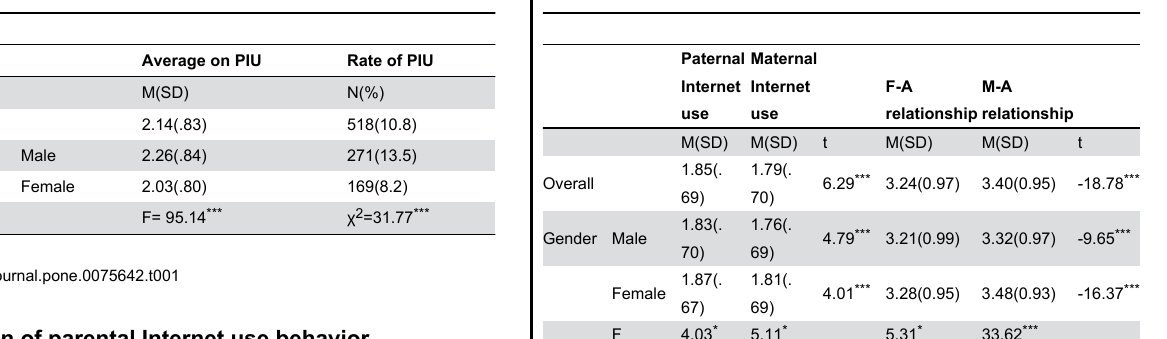
Table 1. Means and Rates of PIU in Male and Female Adolescents.